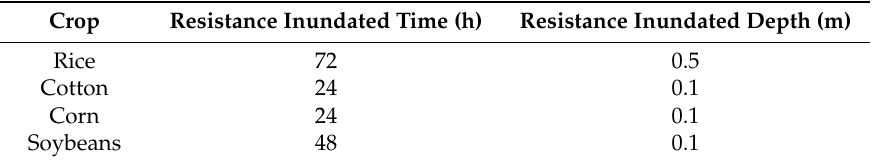
Table 3. Effected parameters by waterlogging.